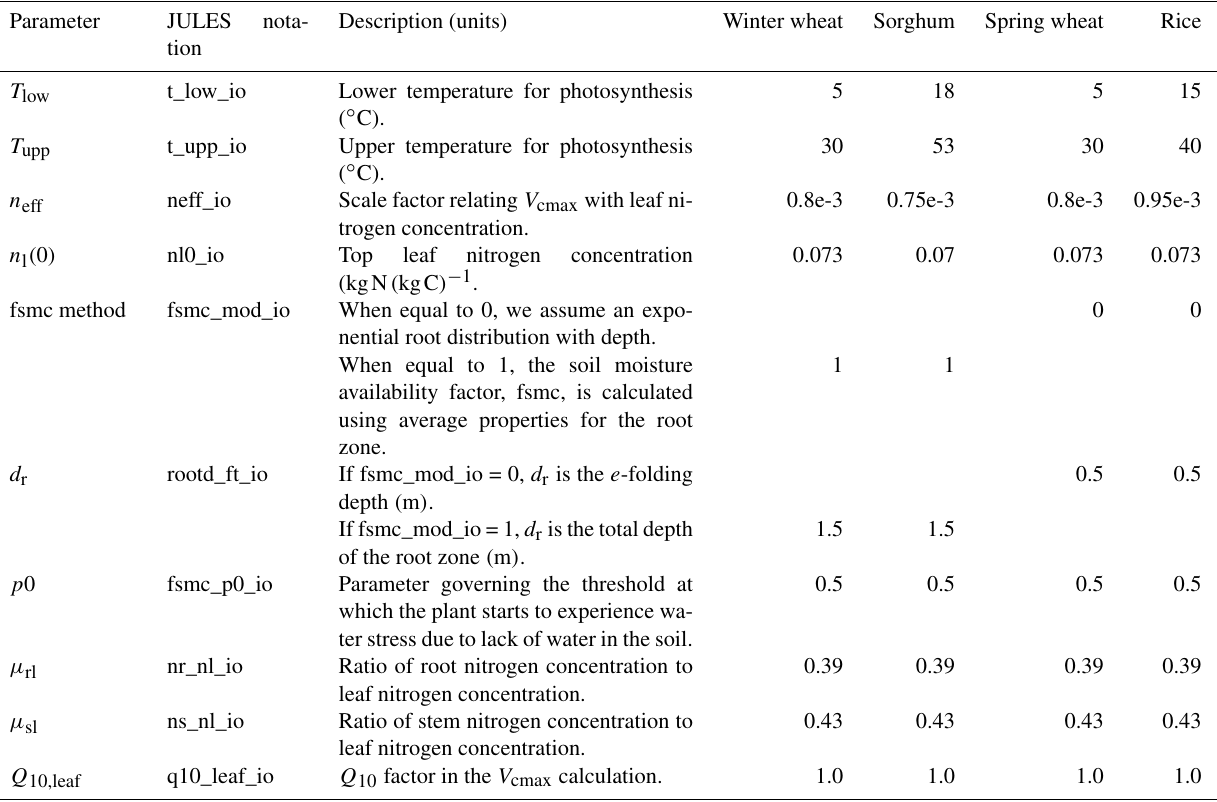
0.8e-3 0.073 0.073 0.073 0 0